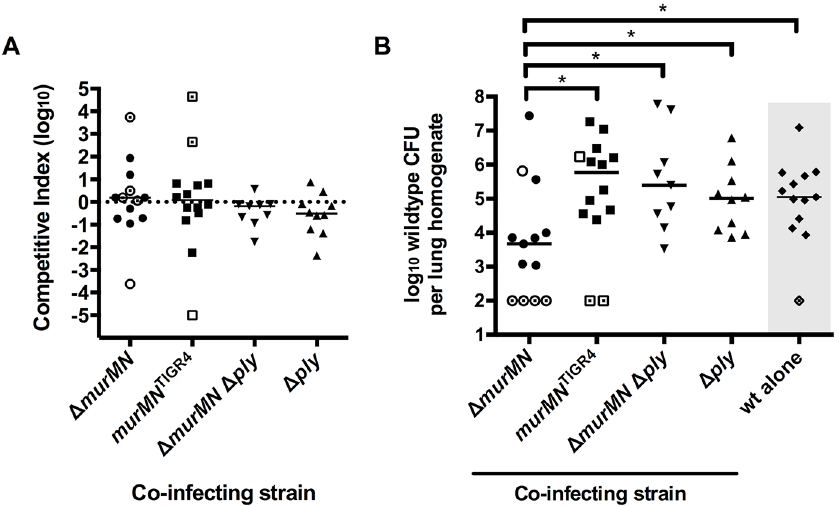
Fig 6. Co-infection with Δ murMN decreases wt burdens in a Ply-dependent manner. Equal amounts of the indicated strains were mixed with wt and administered into the lungs of mice via intranasal inoculation. A competitive index (CI) (A) and the recovered wt titers (B) were determined for each mouse in each sample group. As a control, single-strain infections with wt alone were performed and the titers are depicted in panel B (indicated by the gray box). Each symbol represents an individual mouse and the bars indicate the median CI (A) or median bacterial titer (B) . Open symbols without or with a central dot indicate titers that are at or below the limit of detection of 100 CFU/homogenate for the mutant or wt, respectively. The median bar masks two open, central dot symbols in the Δ murMN dataset. No group in (A) has a median CI that is significantly different from 1.0 as determined by Wilcoxon Signed Rank test. * p < 0.05; Mann-Whitney